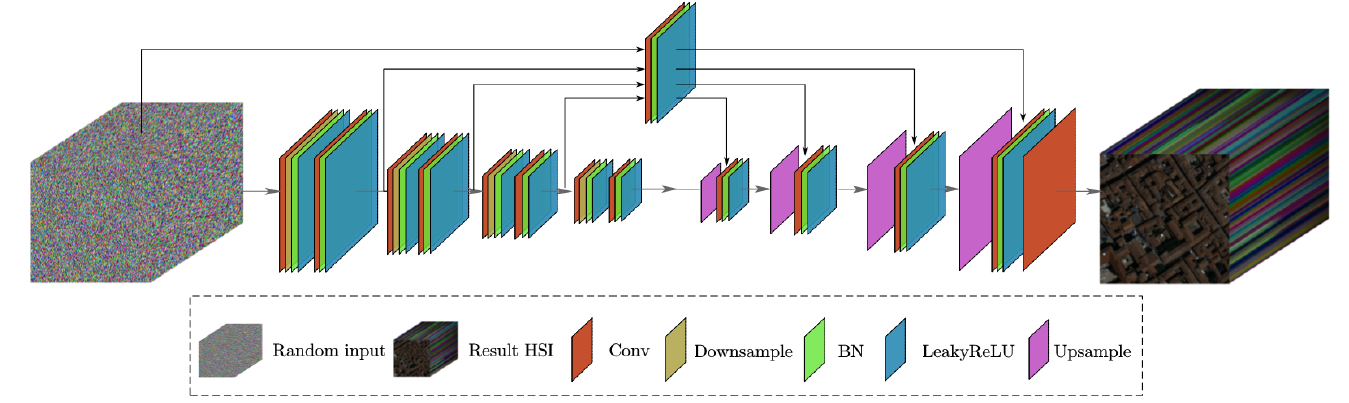
Figure 3. Network architecture used for